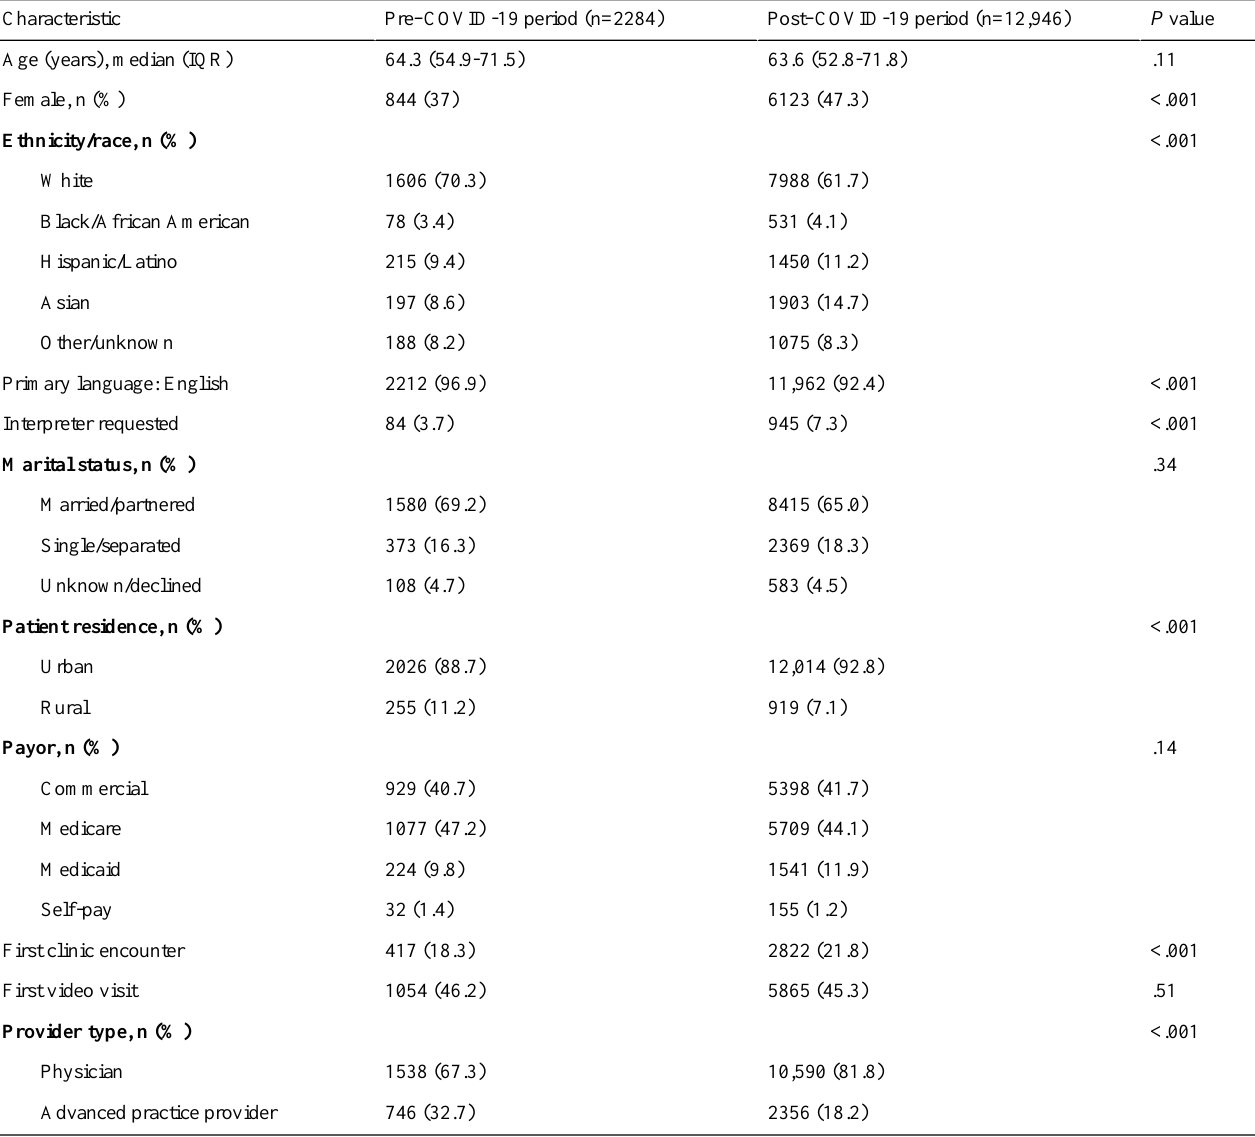
Table 1. Demographics of patients who had video visits pre– and